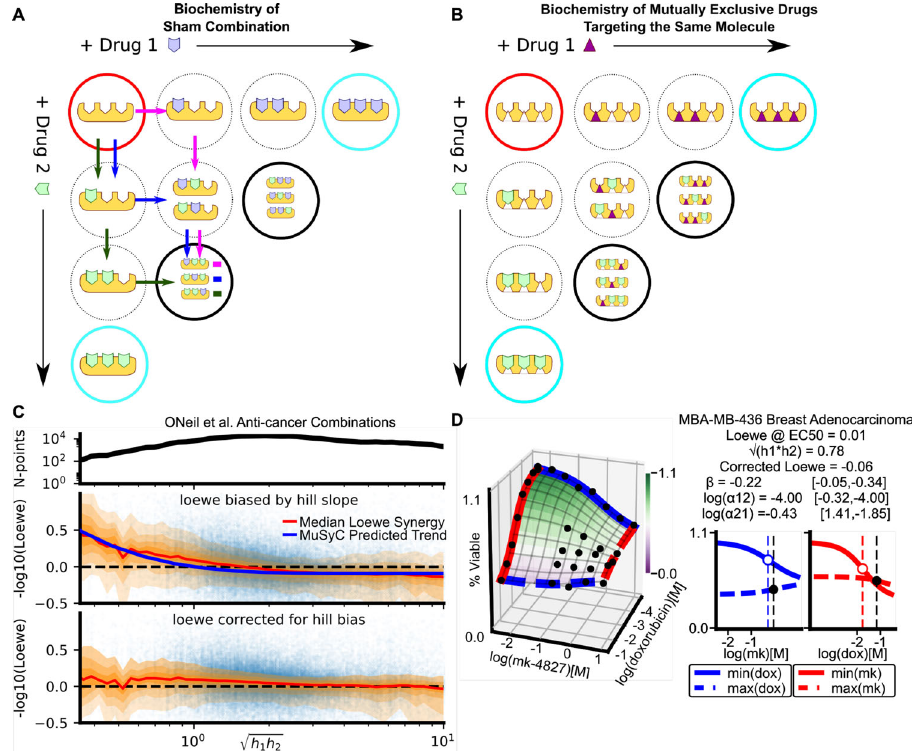
Fig. 5 Hill-slope dependent bias results from enforcing sham compliance DEP-based frameworks. A An illustration of the unique biochemistry of the sham experiment. The red circle represents an undrugged molecule with three binding sites. In a sham experiment, a drug is treated as though it were two separate drugs (green and blue polygons). Mixed states in which the binding sites are bound by both green and blue drugs (black circles) are equivalent to fully drugged states (cyan circles). We highlight three paths (green, blue, magenta arrows) that can be followed to reach a mixed-drugged state. These three paths correspond to the coef fi cient of 3 d 1 d 2 2 in Eq. (19) in Box 2. B In a combination of mutually exclusive drugs (triangle and polygon), targeting the C 3 same molecule, and with the same number of binding sites, the mixed states (black circles) are not equivalent to fully drugged (cyan circles) accounting for the discrepancy between MuSyC and the sham experiment (Box 2). C Loewe synergy is biased by Hill slope in the anti-cancer drug screen 26 . The orange shaded regions show moving window percentiles (window width is 0.1) of Loewe (10th through 90th percentiles, in steps of 10). The top panel shows how many data points are present in the window. The blue curve in the middle plot shows the median MuSyC-predicted bias as a function of the geometric mean of the Hill slopes (see Methods section). Subtracting the MuSyC-estimated bias (calculated for each data point) from Loewe yields the bottom plot. D The antagonistically ef fi cacious and potent combination of mk-4827 and doxorubicin 26 is misidenti fi ed as synergistic by Loewe, because both drugs in isolation have Hill slopes h < Table 3 Summary of the datasets used for comparisons and validating theoretical predictions by MuSyC. Model # of Combinations Metric of drug effect Effect range Refs.